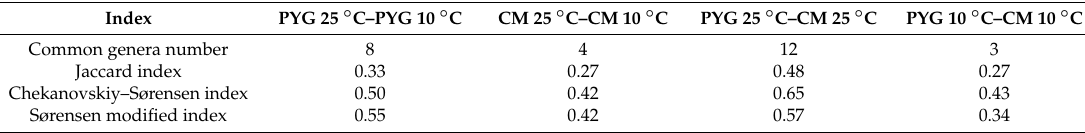
Table 2. Ecological indices of cultured communities’ similarity.